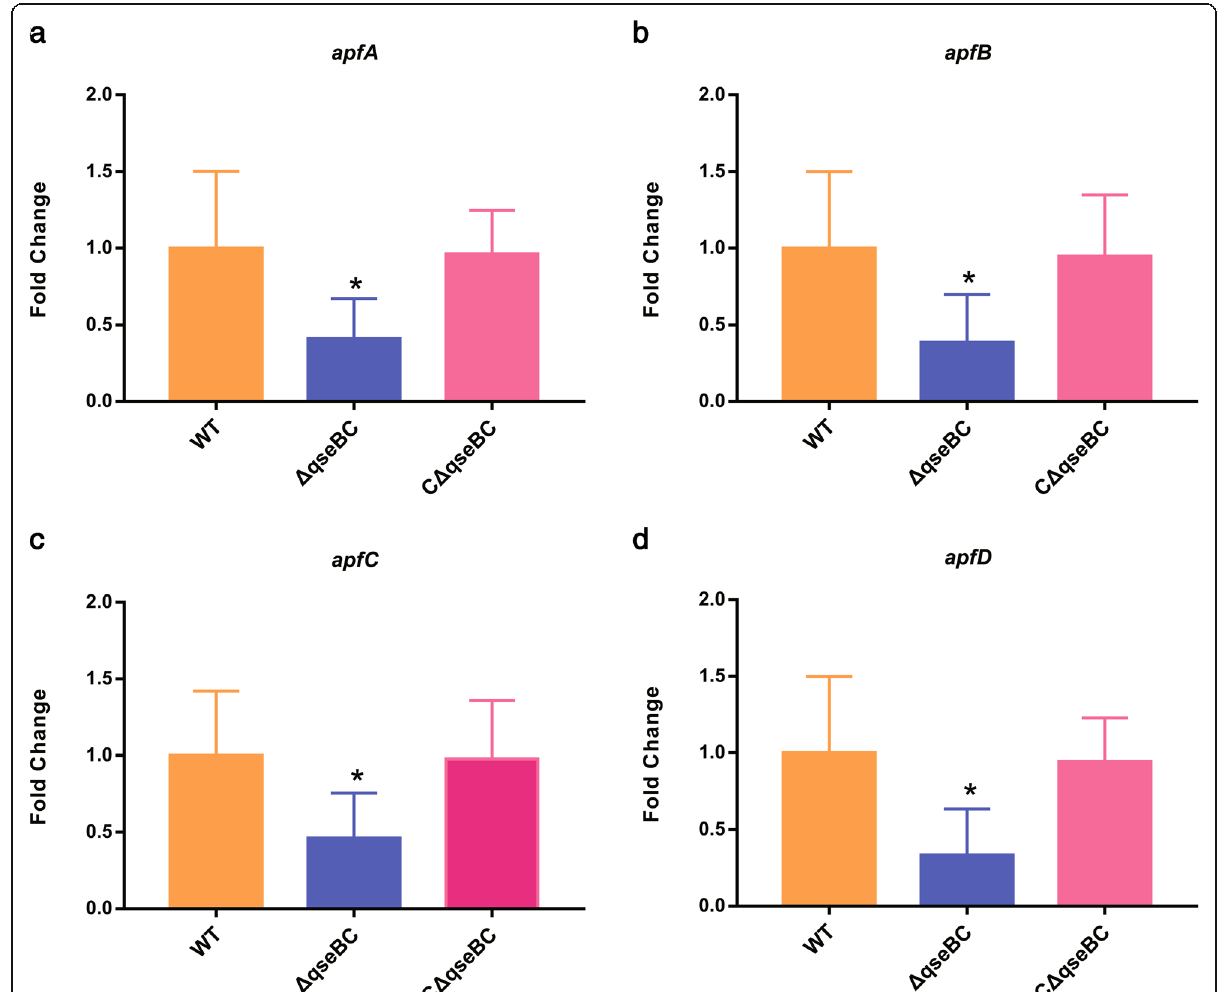
Fig. 1 Effect of qseBC deletion on the transcription of apf gene cluster. RT-qPCR analysis of transcription levels of genes in the apf gene cluster in WT S4074, Δ qseBC and C Δ qseBC strains. mRNA levels were normalized to 16S rRNA gene for each strain. Data are shown as mean ± SD ( N = 3). * P <